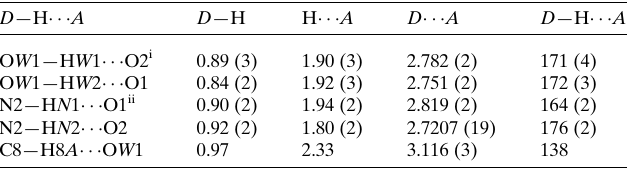
Table 3 Hydrogen-bond geometry (A˚ , (cid:3) ) for ( III ).